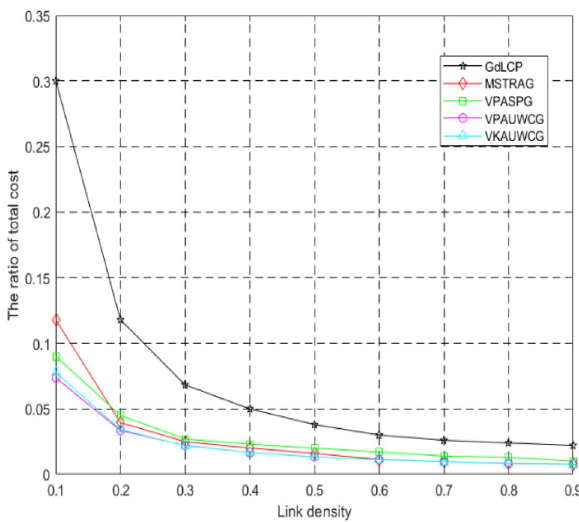
Figure 7. Ratio of total cost of different link density ρ.